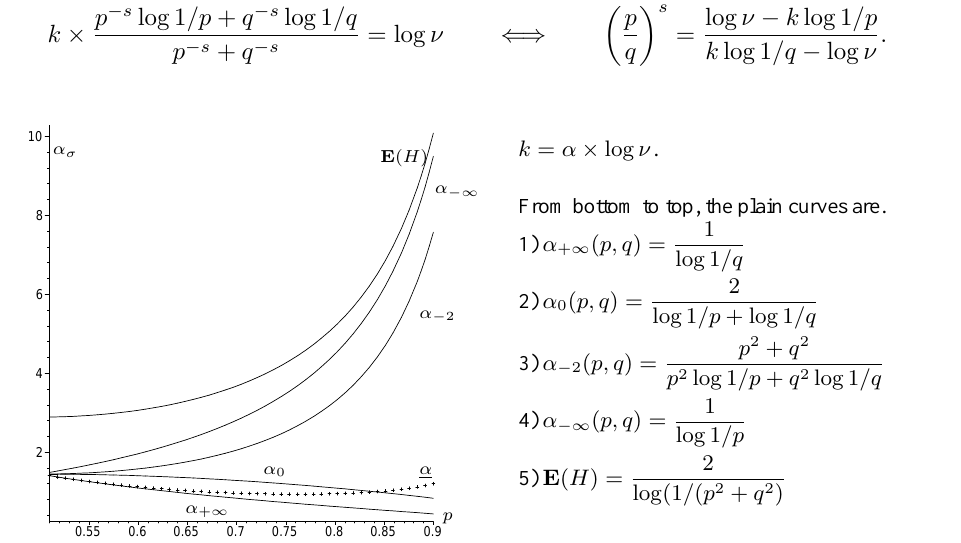
Fig. 1: Range of values of k and corresponding saddle-point σ (index of α ). The top curve represents the expectation of the height H of the trie. The dotted curve plots the values of the lower bound α that is defined in Definition 4 and used in Theorem 5 and 6. It is well known that, when p = q = 1 / 2 , almost all leaves are at depth close to the fill-up (saturation) level which is well approximated by α + ∞ . This explains the shape of the region for which the saddle-point σ is real ( α ∈ ] α + ∞ , α −∞ [